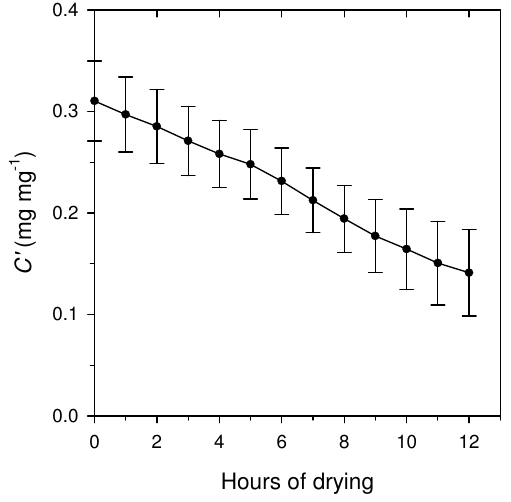
Fig. 4. Means and standard error of stored water in T. recurvata after 1h wetting by simulated fog at ≤ 30%RH and 22 ◦ C.